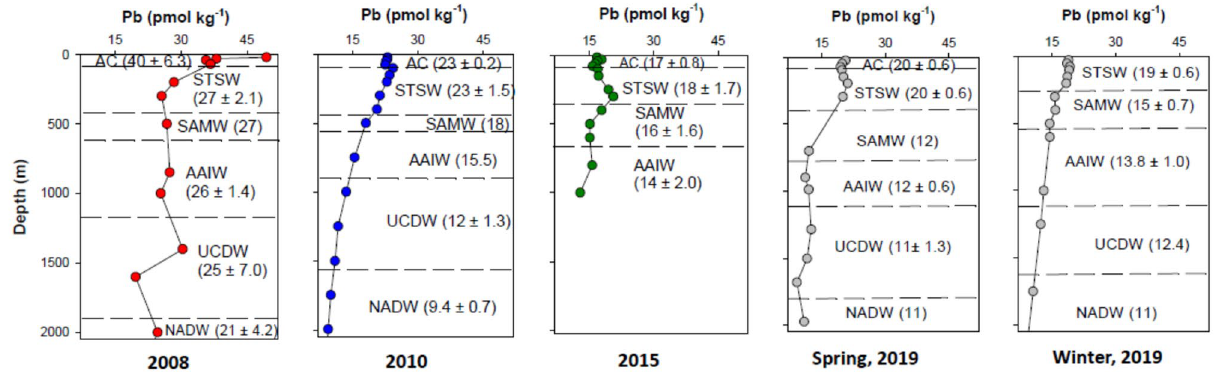
Figure 5. Vertical dPb distribution over time at station GT10 in the Cape Basin. Different water masses encountered with depth are identified and their respective average dPb ± 1σ concentrations are given in brackets. Water masses were identified based on Fig. 4. Data for the years 2008 and 2010 were previously published 30,31 . AC water mass is not evident in 2019 due to its minimum contribution in winter (discussed in section "Seasonal variation of AC-derived Pb to the Cape